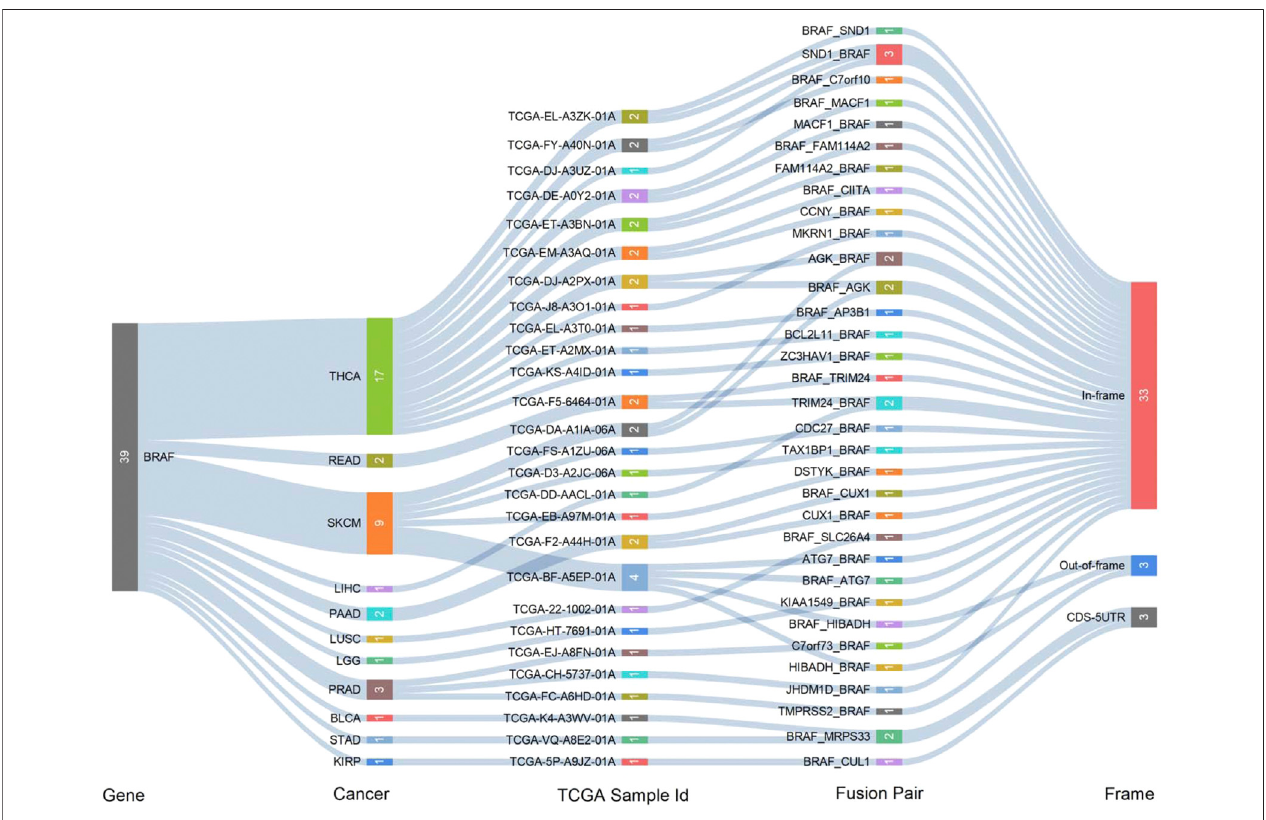
FIGURE 3 | Gene fusions of BRAF across different cancer